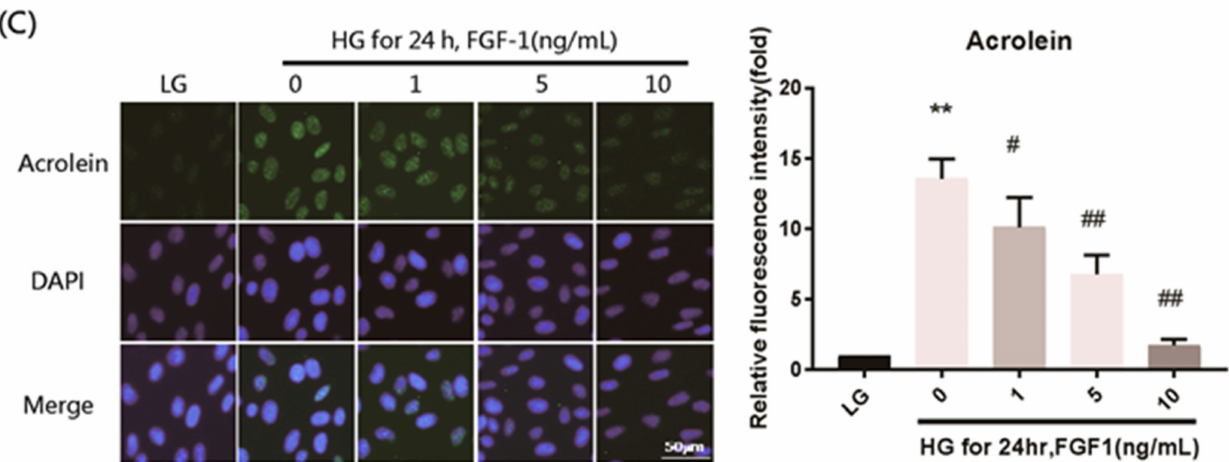
Figure 4. FGF-1 treatment ameliorated cell oxidative stress in ARPE-19 cells incubated in high-glucose medium. After pretreatment with a series of different concentrations of FGF-1 (1, 5, and 10 ng/mL) for 2 h, ARPE-19 cells were incubated in a high-glucose (25 mM) medium for 24 h. Expression of oxidative stress mediators ( A ) 8-OHdG, ( B ) nitrotyrosine, and ( C ) acrolein were detected using immunofluorescence (IF) imaging ( n = 5 in each group). The relative fluorescence signals of the IF image were quantified using ImageJ software. * p < 0.05, ** p < 0.01 compared with the control cells incubated in the low-glucose medium; # p < 0.05, ## p < 0.01 compared with ARPE-19 cells incubated in high-glucose medium. DAPI, 4 (cid:48) ,6-diamidino-2- phenylindole; LG, low glucose; HG, high glucose; FGF-1, fibroblast growth factor type